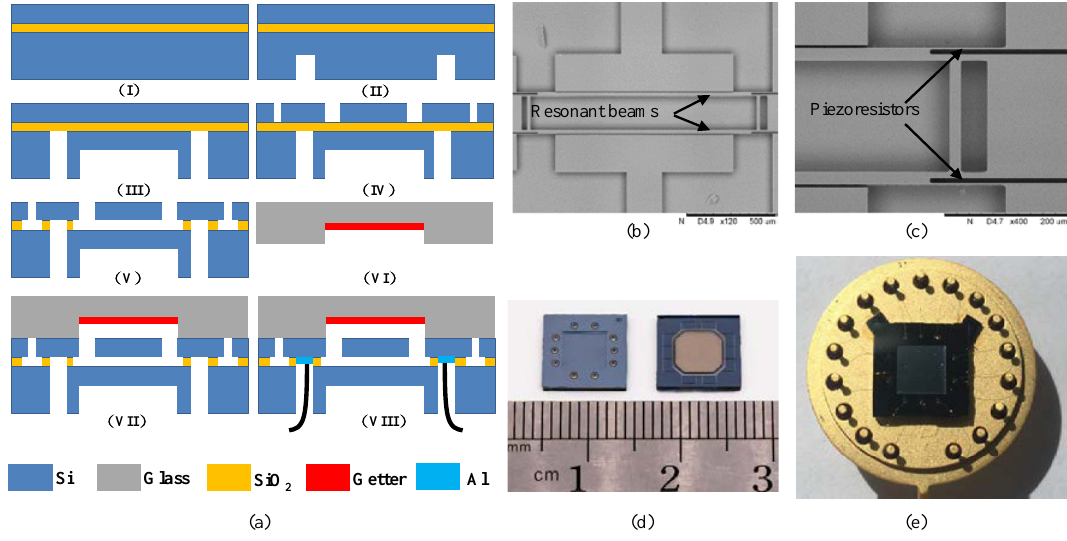
Figure 2. ( a ) The fabrication process of the resonant pressure microsensor: ( I ) thoroughly clean the SOI wafer, ( II ) and ( III ) form the pressure sensitive membrane and the holes for electrical connections, ( IV ) pattern the device layer, ( V ) release the oxide layer beneath the resonators, ( VI ) deposit a layer of getter material on glass covers, ( VII ) conduct silicon-to-glass anodic bonding, ( VIII ) form electrical connections. ( b , c ) SEM pictures of fabricated resonators based on double-ended tuning forks. ( d , e ) The pictures of the fabricated sensors before and after forming electrical connections with the surrounding